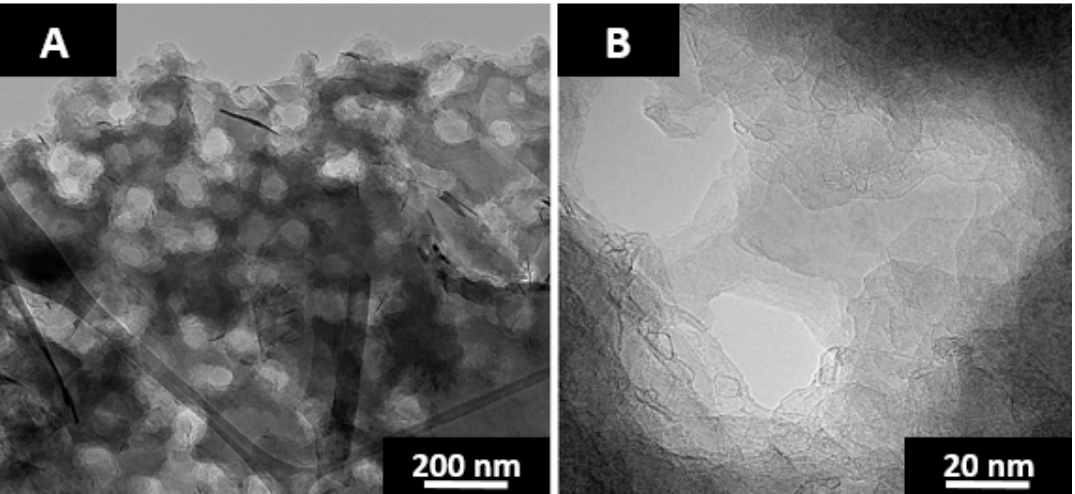
Figure 10. TEM micrographs of CO 2 laser heated ( A ) anthracene-fluorene–pyrene coke and ( B ) pore structure. Table 1. XRD crystal structure of anthracene coke and SCG—2600 °C, 1 h.